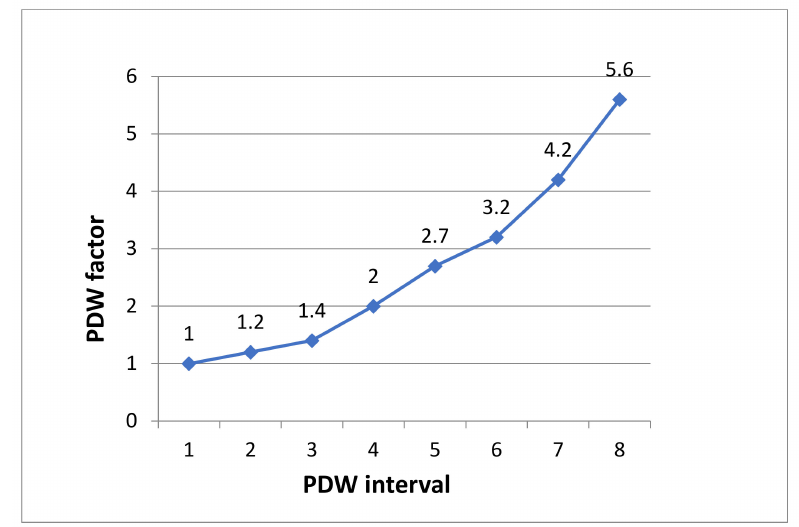
Figure 2. Calculated PDW factors for respective PDW